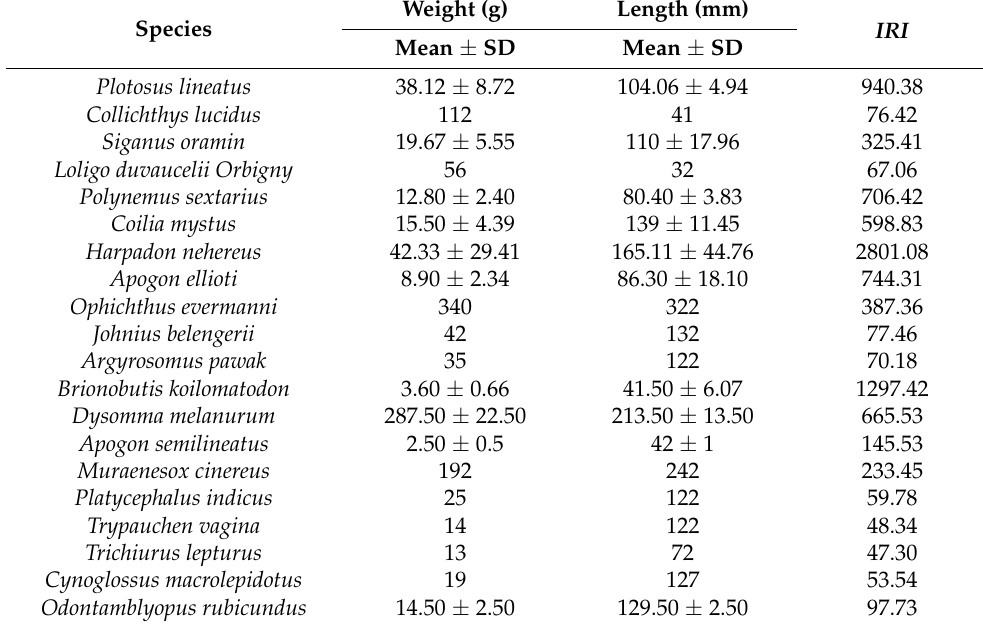
Table 3. Catch data of the fish species in the Jinwan offshore wind farm area.